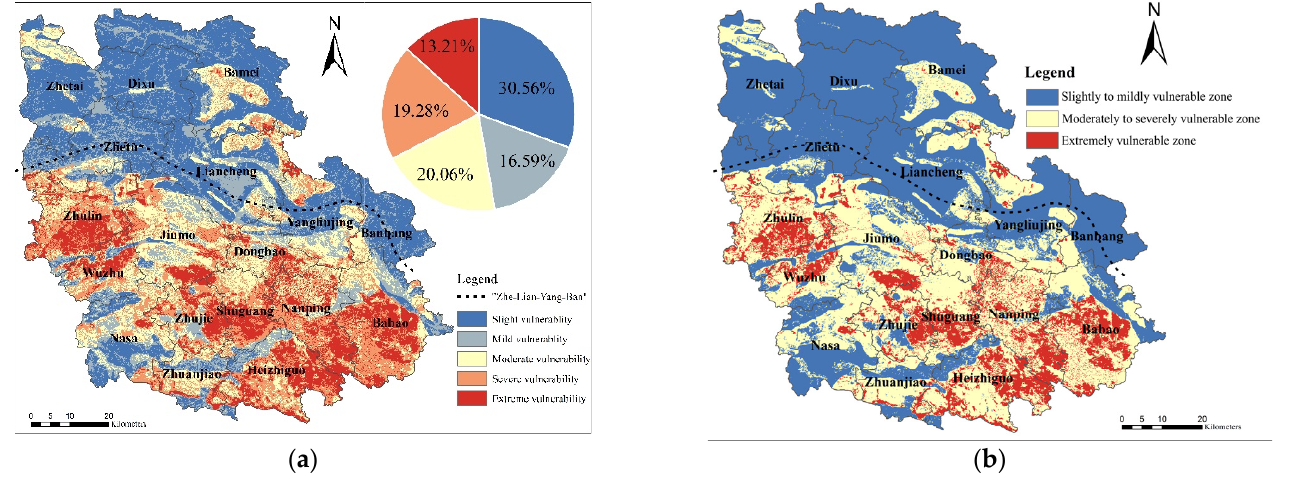
Figure 3. Spatial distribution of ecological vulnerability areas and ecologically vulnerable zones in Guangnan County. ( a ) Spatial distribution of ecological vulnerability areas; ( b ) Spatial distribution of ecologically vulnerable zones.